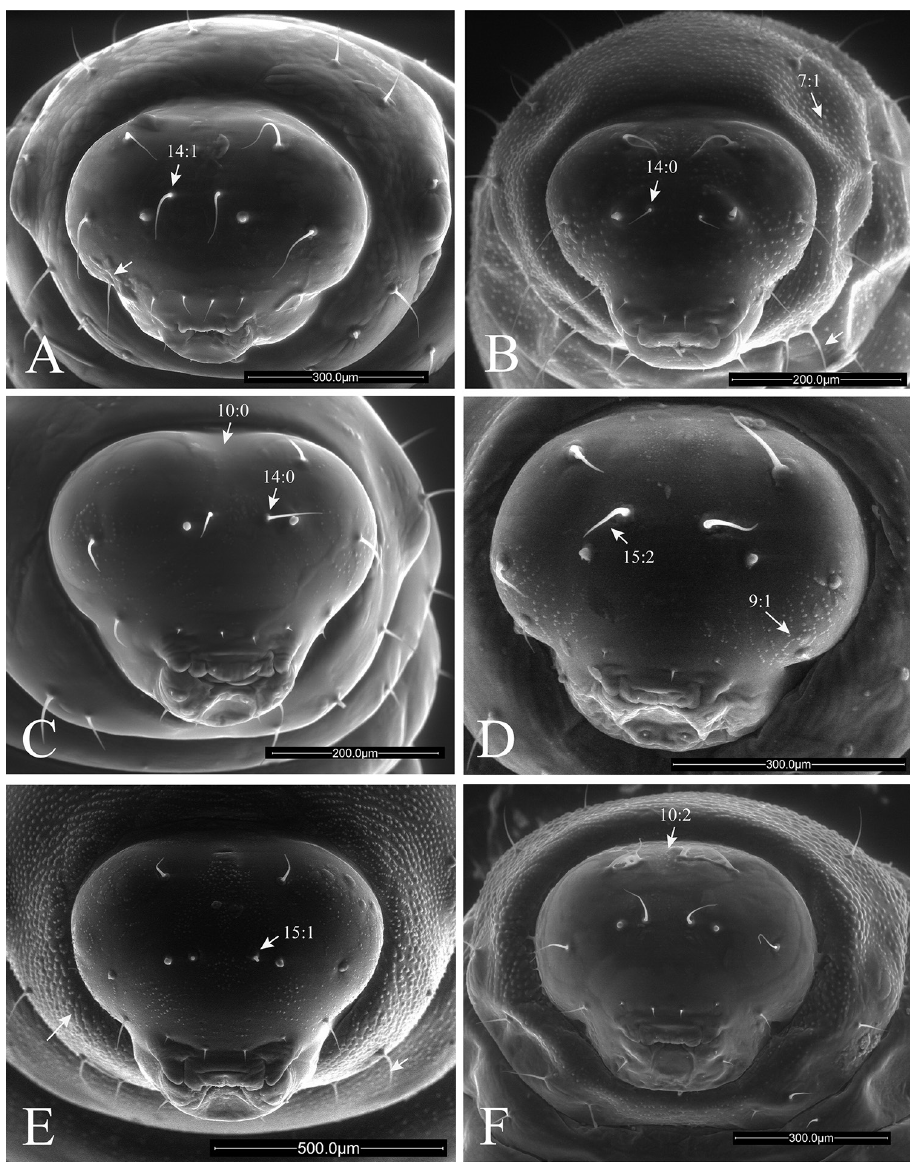
Figure 7. Anterior views of head of Ormyrus terminal-instar larvae. A Ormyrus capsalis B O. cupreus C O. diffinis D O. gratiosus E O. nitidulus F O. orientalis . Character states for outstanding features are